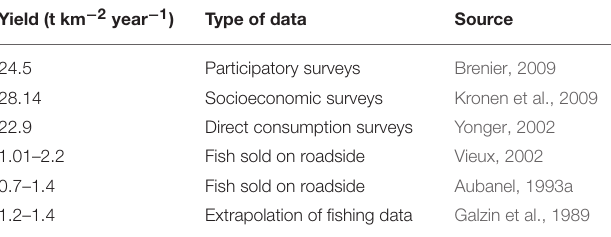
TABLE 3 | Yield estimates per surface area unit by type of